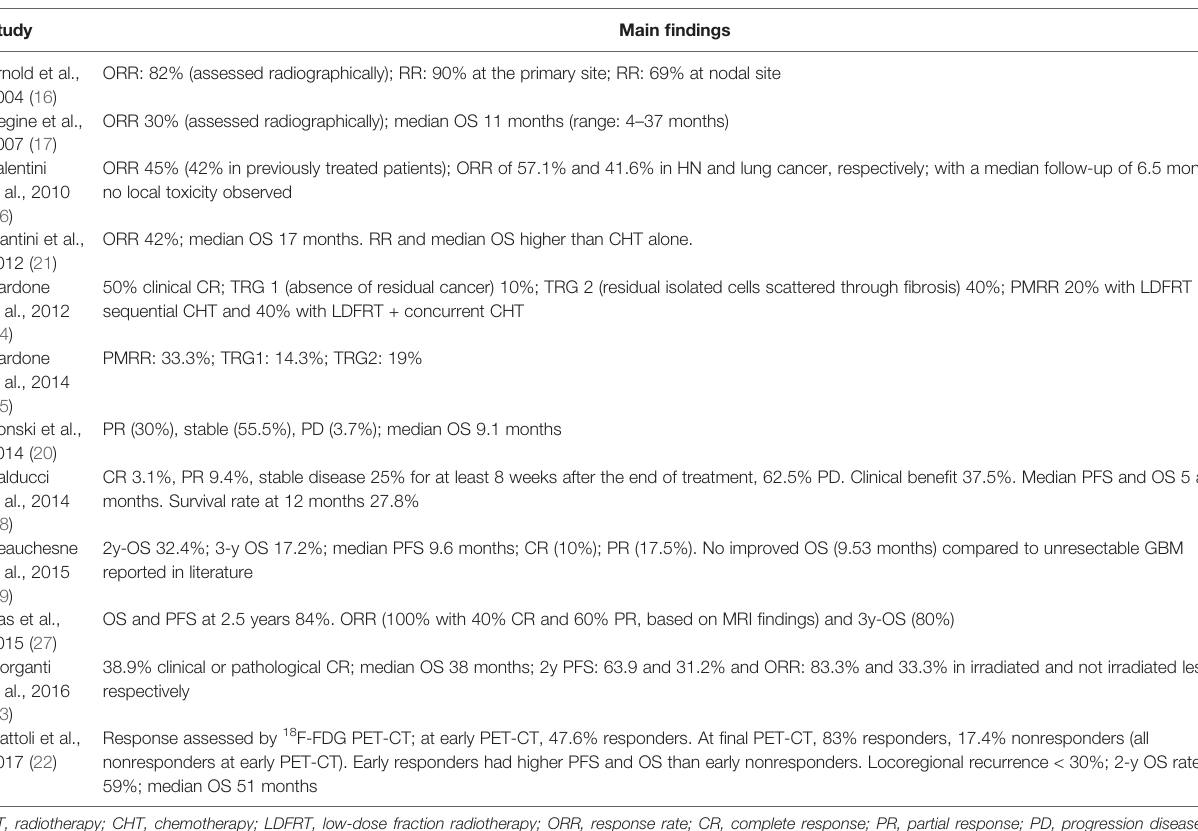
TABLE 3 | Response and